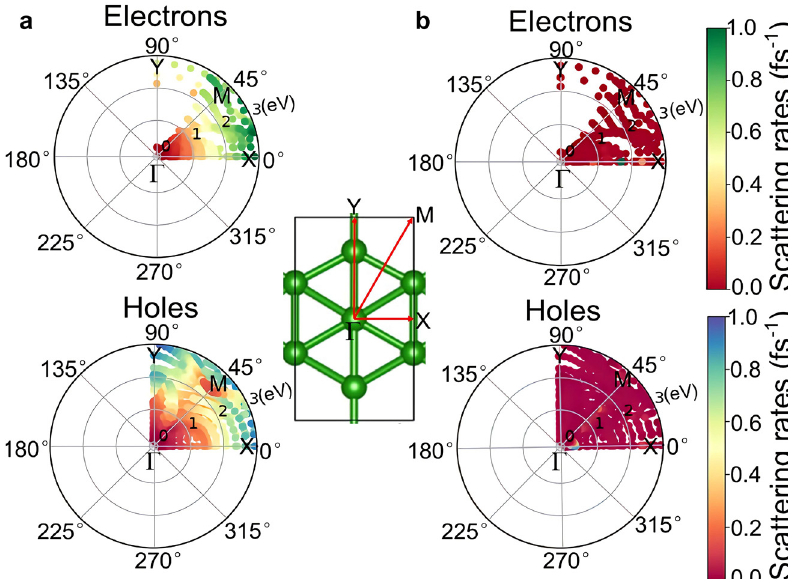
Figure 8: Electron – electron(a) andelectron – phonon (b) scattering rates as a function of energy and momentum direction in borophene monolayer. The radial coordinatesineachpanelarethehotcarrier energy relative to the Fermi energy, and the angular coordinates correspond to the hot carrier momentum directions. The color indicates the values of scattering rates.